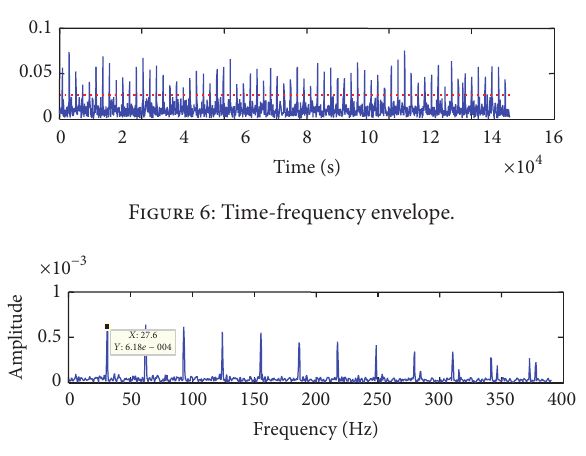
Figure 7: The spectrum of resonance demodulation.